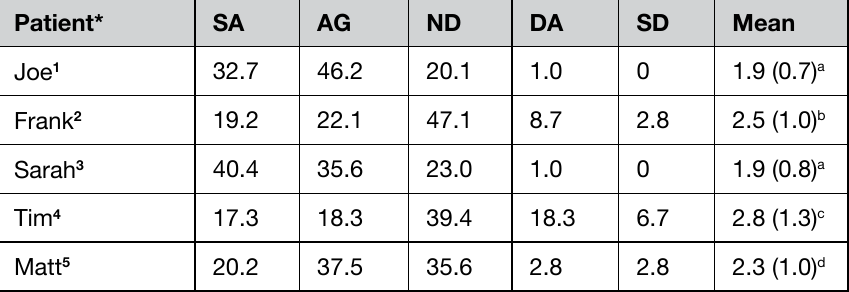
Table3: Frequencies and mean students rating of their willingness to evaluate and treat patients living with